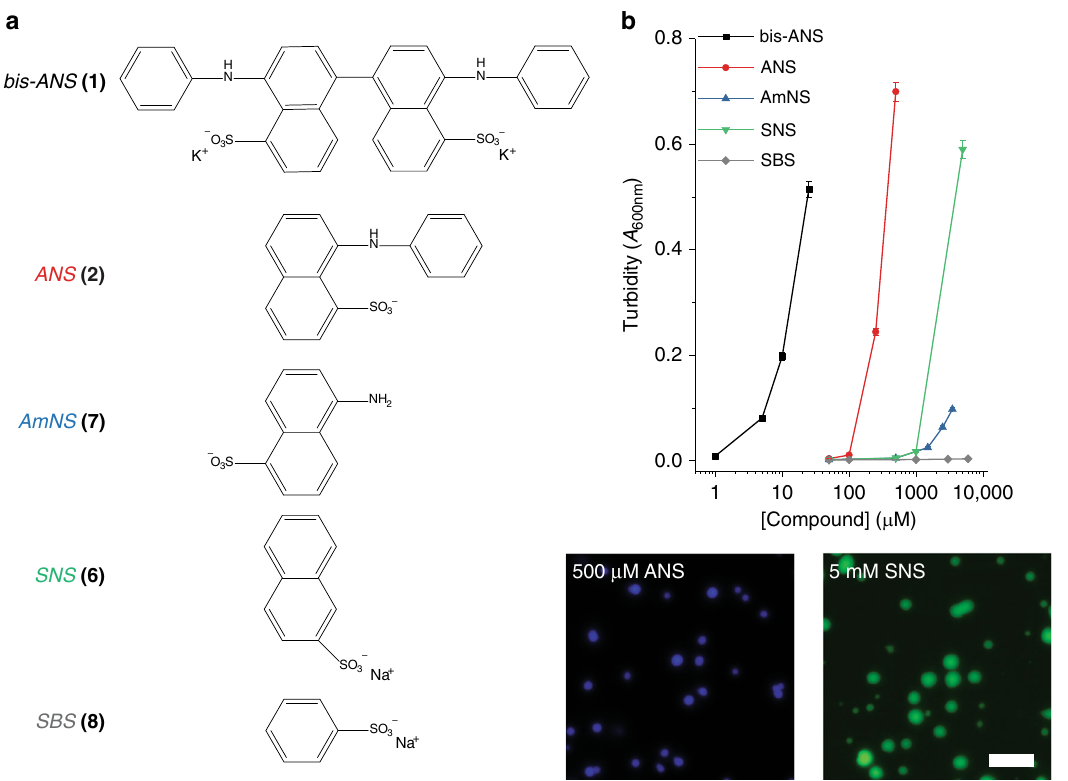
Fig. 4 Comparison of the ability for naphthalene sulfonate derivatives to induce TDP-43 LCD LLPS. a Chemical structures of naphthalene derivatives: bis-ANS ( 1 ), 8-anilinonaphthalene-1-sulfonic acid (ANS, 2 ), 5-amino-1-naphthalenesulfonic acid (AmNS, 7 ), sodium 2-naphthalene sulfonate (SNS, 6 ), and sodium benzene sulfonate (SBS, 8 ). b Turbidity as a function of compound concentration for chemicals depicted in panel ( a ) (top panel) and representative fl uorescence microscopy images of droplets formed in the presence of ANS or SNS (bottom panels). Droplets containing SNS were imaged using protein doped with Alexa Fluor 488-labeled TDP-43 LCD. Experiments were performed in a 20 mM potassium phosphate buffer, pH 6.0, using 10 μ M His-tagged TDP-43 LCD. Scale bar: 10 μ m. All data are presented as mean values± standard deviation ( n = 3 technical